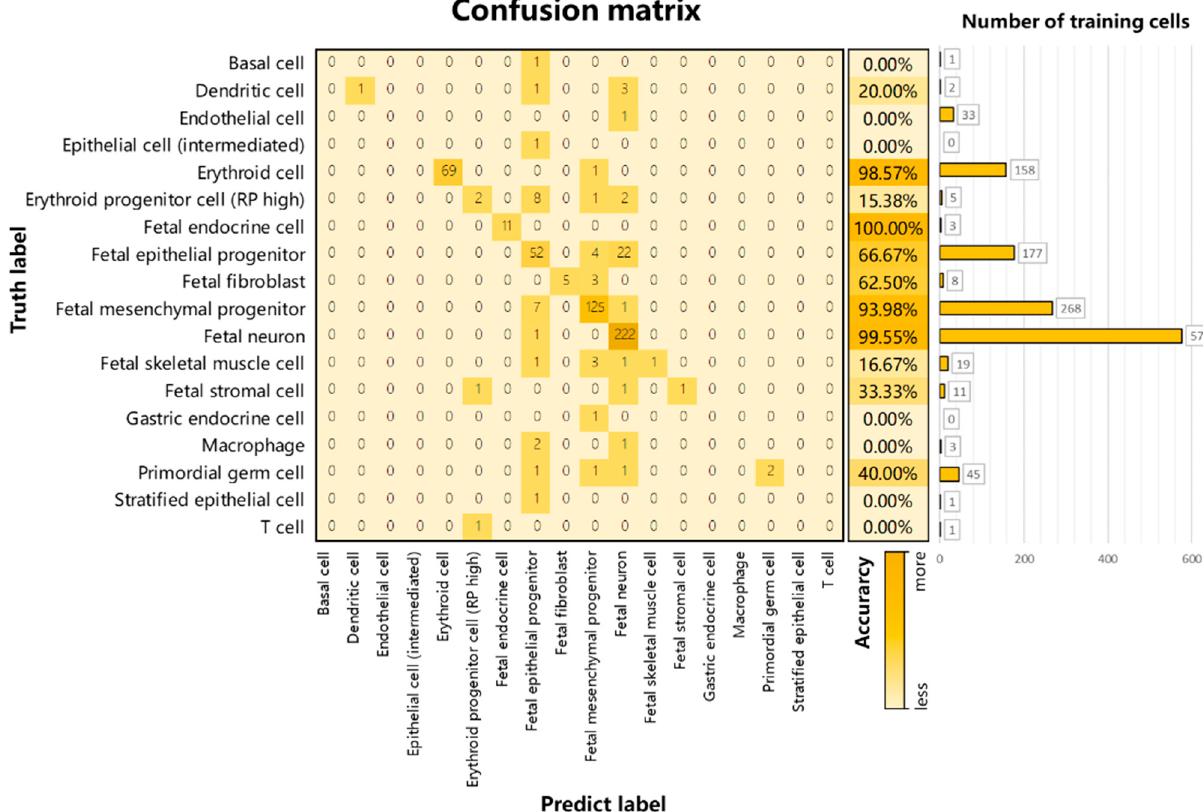
Figure 3. Confusion matrix of scTransSort classification results on the human fetal eye dataset. The accuracies in the graphs represent the accuracy of the predicted results for each cell label, respectively. The bars represent the number of cells in the training dataset for each cell label.